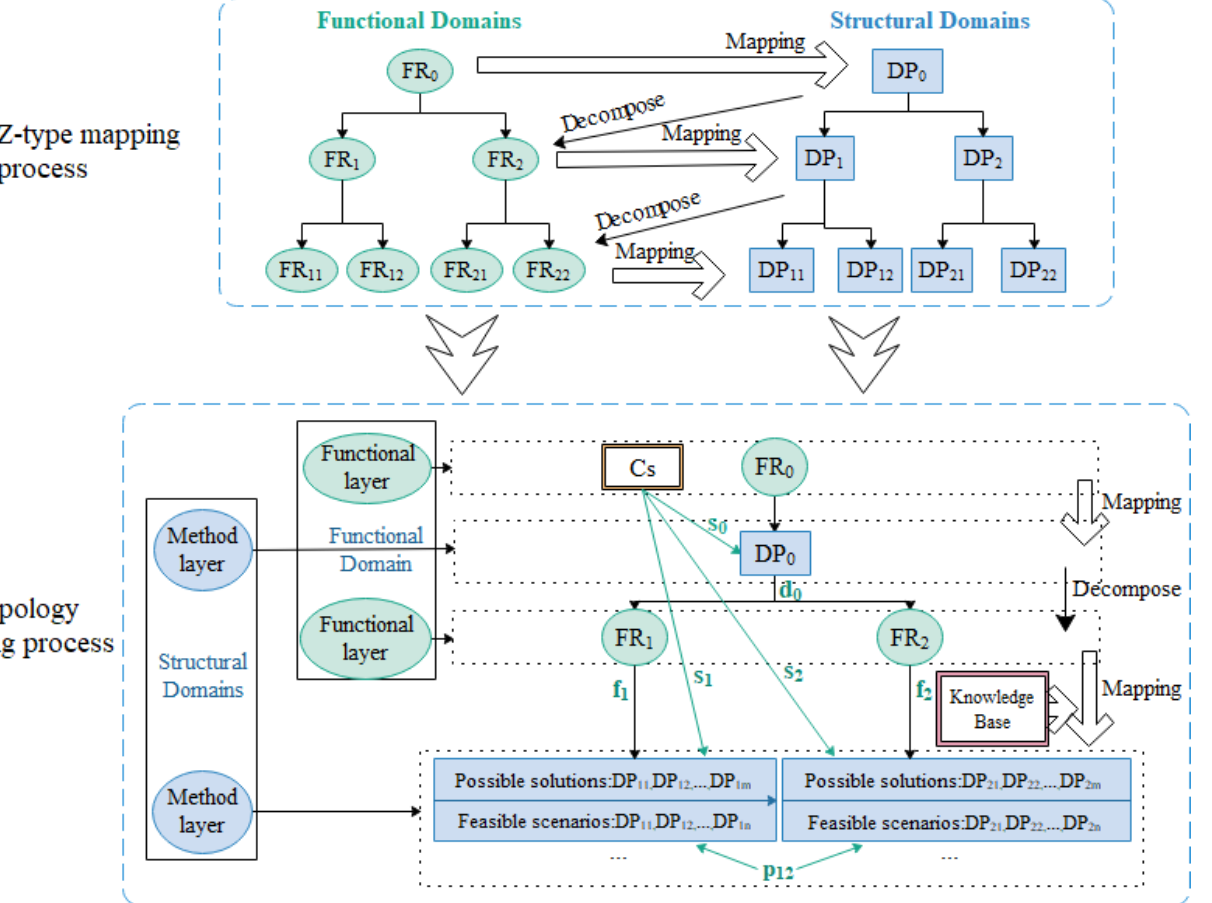
Figure 3. Tree topology mapping process.